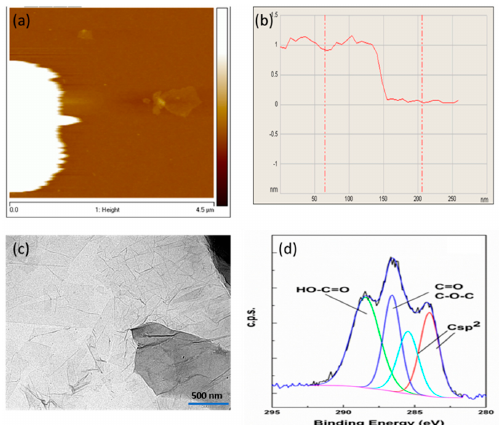
Figure 2. Exfoliated graphene oxide (GO) monolayer atomic force microscopy (AFM) image by non-contact mode ( a ) and vertical height of the sheet ( b ); ( c ) TEM image (scale bar 500 nm); ( d ) Experimental, high-resolution XPS C1s peak of the GO employed in the present study and its best deconvolution fit to individual